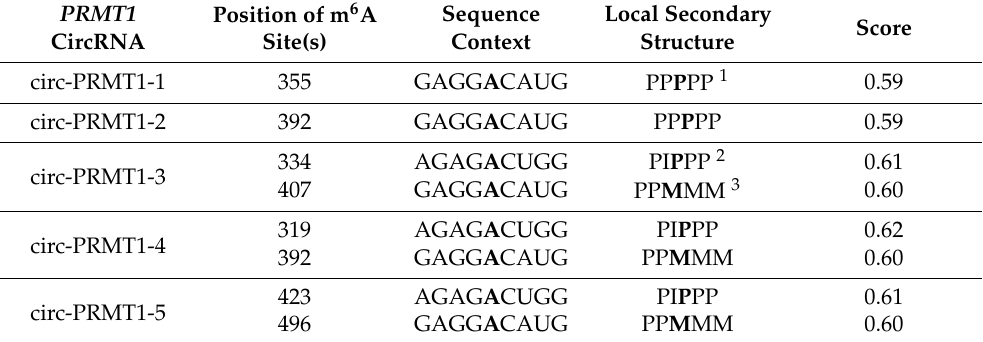
Table 4. The predicted m 6 A sites of the novel PRMT1 circRNAs that possess an open reading frame (ORF), according to the SRAMP tool. For each m 6 A site, the exact position on the respective circRNA sequence and the overall score is presented. The overall prediction score is calculated by combining the scores from K-nearest neighbor encoding, positional binary encoding, and nucleotide pair spectrum encoding. The specific adenine (A) which is modified, as well as its secondary structure, are shown in bold.